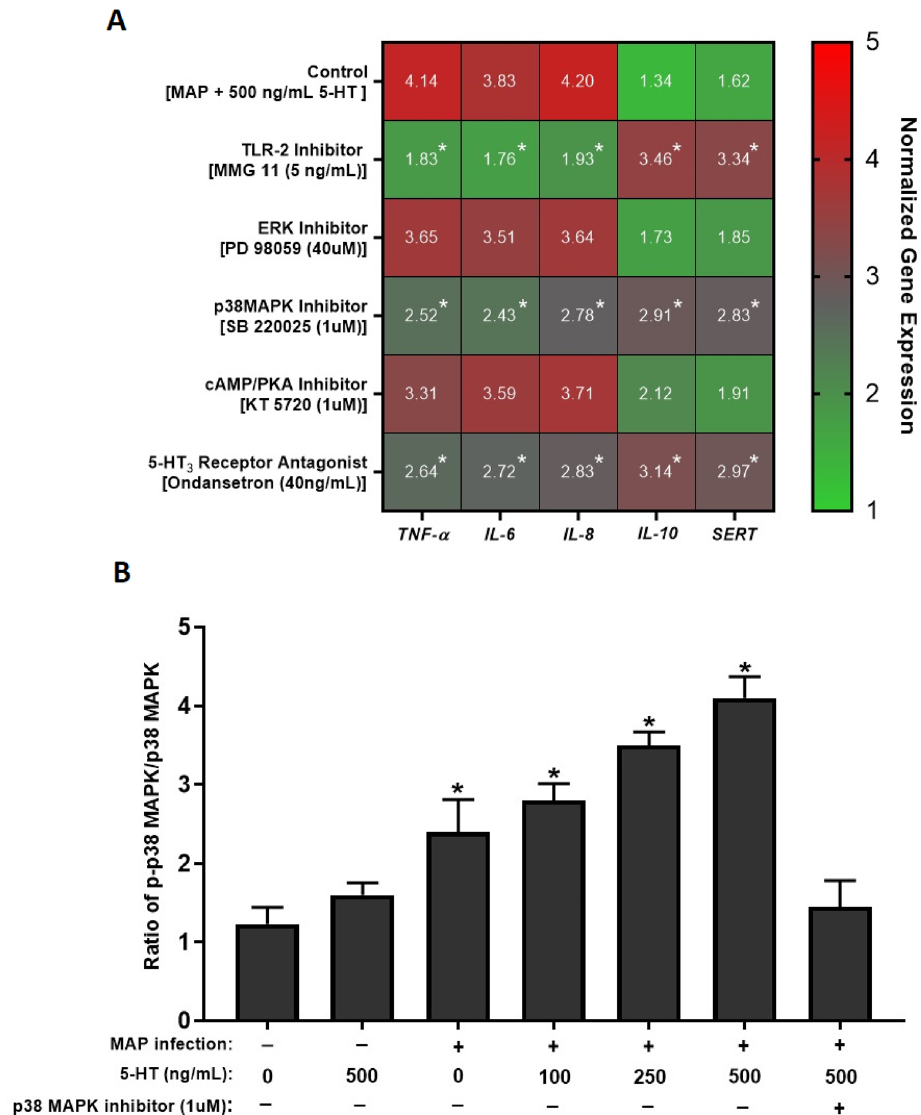
Figure 7. ( A ) Effects of several inhibitors involved in TLR-2 signaling pathway on expression of TNF-α, IL-6, IL-8, IL-10 and SERT in MAP-infected Caco-2 monolayers in the presence of excess level of 5-HT (500 ng/mL) following 24 h of incubation. Values were normalized to relative gene expression level of control monolayers without 5-HT treatment or infection. ( B ) The effect of MAP infection on the ratio of p-p38 MAPK/p38 MAPK in the presence of different levels of 5-HT (0, 100, 250, 500 ng/mL) with or without 1 uM of p38 MAPK inhibitor (SB220025) following 24 h of incubation. Values were pre-tested for normal distribution using the Kolmogorov–Smirnov normality test. Significance among experiments was assessed by two-way analysis of variance (ANOVA) followed by Bonferroni correction test. All RT-PCR and phosphorylation activity of p38 MAPK experiments were performed in triplicates. Data are presented as Mean ± SD. * P value <